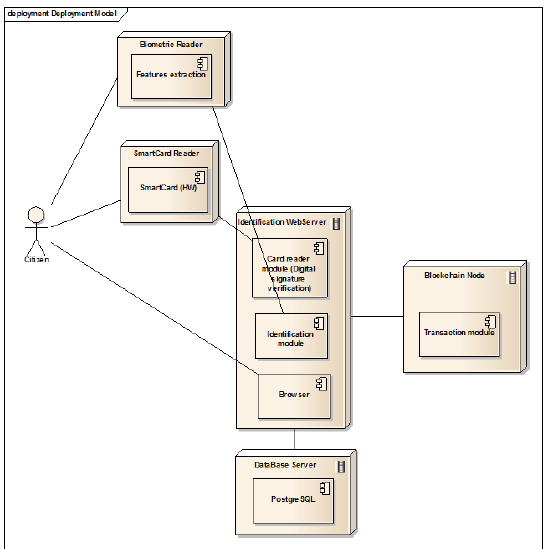
Figure 4. Deployment model.